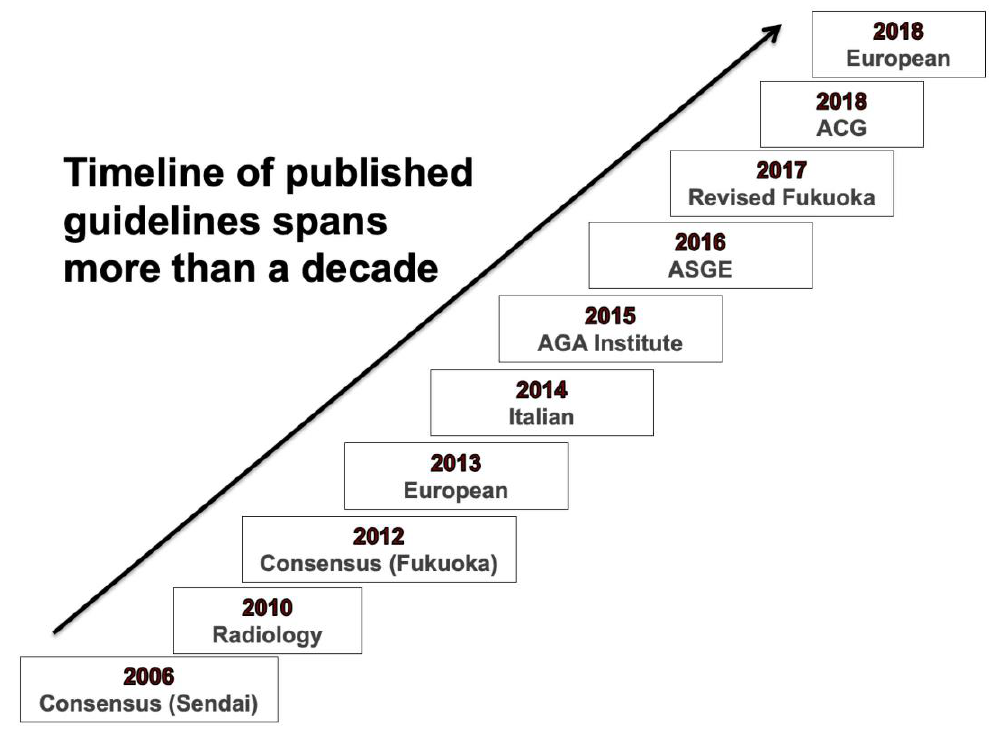
Figure 1. Timeline of published guidelines for the management of pancreatic cystic lesions.